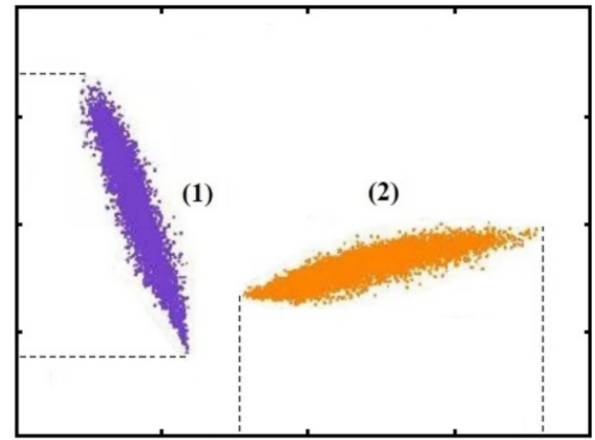
Figure 2. Simplified distortion diagram of different distributions for